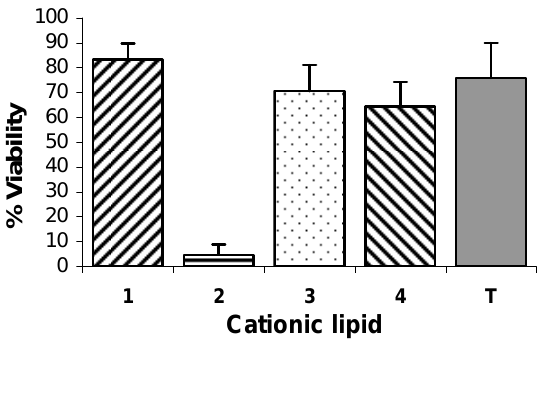
Figure 9. Comparison of cell viability of HeLa cells after transfection with lipoplexes at their optimal cationic lipid/siRNA ratios and compared with the commercially available transfection agent TransIT TKO (T). Values are presented as mean ± SD (n = 6). Experiments were carried out at: 0.6  g/well synthesized cationic lipids, 1.5 pmol siRNA/well (15 nM), and 6,500